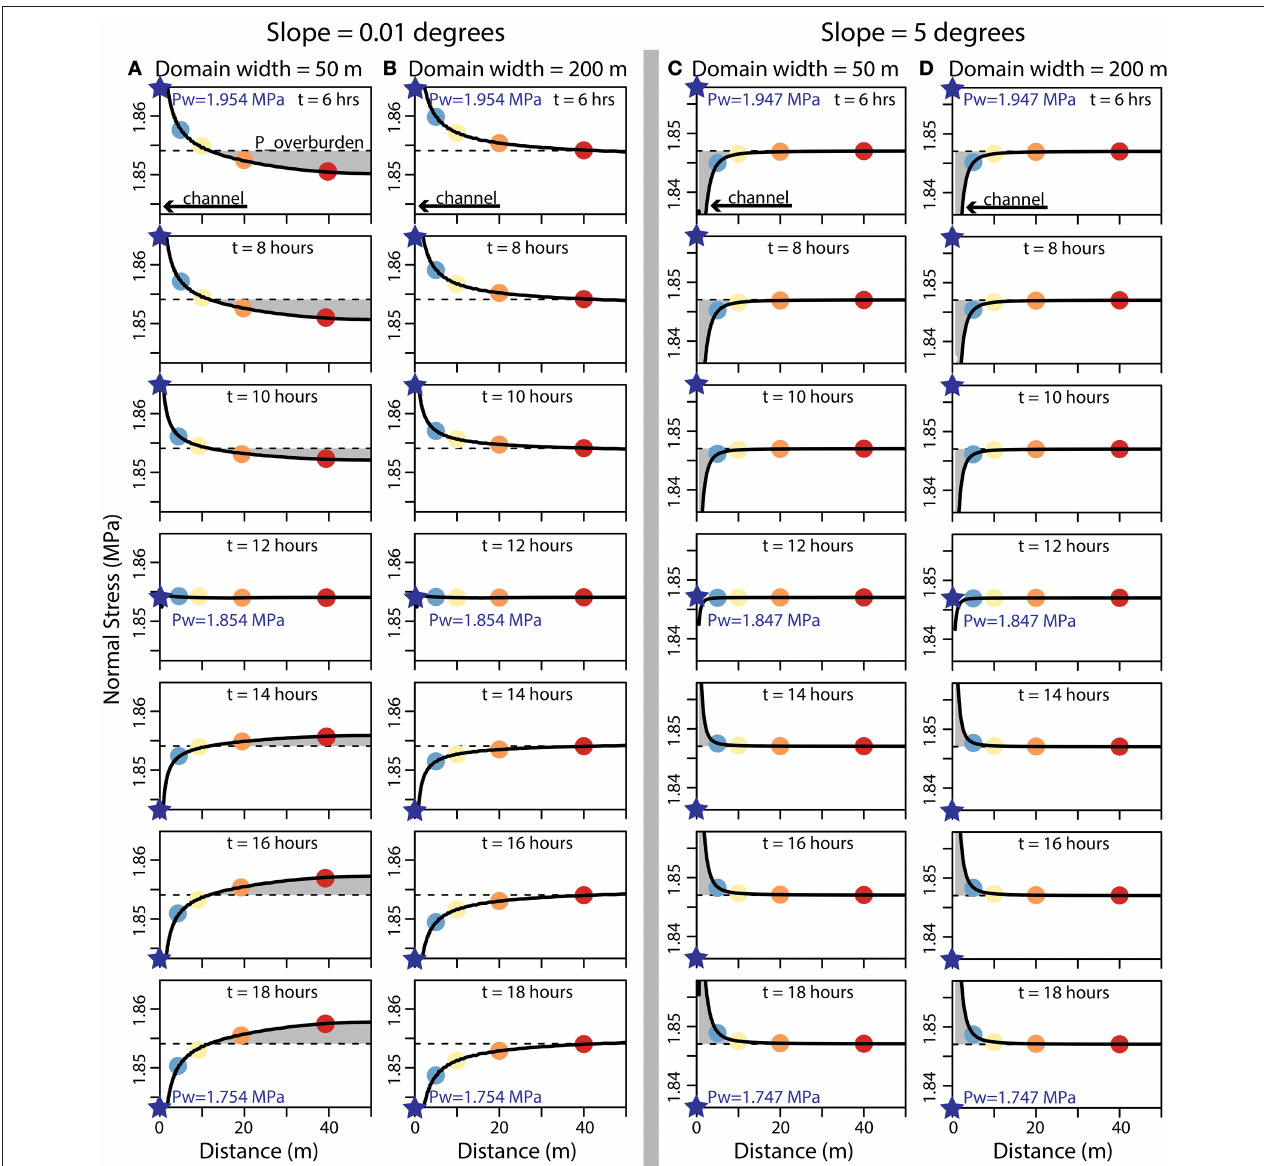
FIGURE 6 | Normal stress profile at the glacier bed from 6 to 18h after initialisation for a flat bed with (A) a domain width of 50m and (B) 200m and (C,D) for a bed slope of 5 degrees with the same domains. The anti-correlation between the water pressure (blue star) in the channel (radius of 0.5 m) and a point on the bed is shaded in grey. Points in blue, yellow, orange, and red highlight the normal stress at 5, 10, 20, and 40 m from the channel centre, respectively and are plotted over time in Figure 7